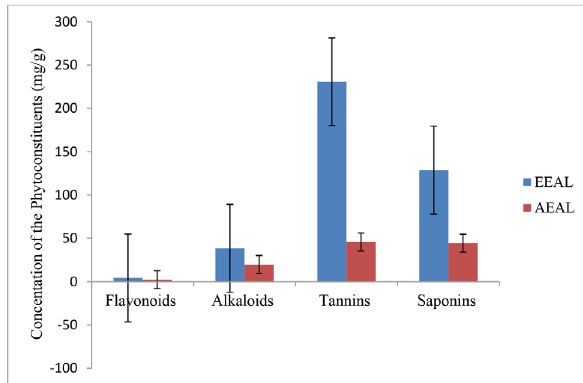
Figure 1 Quantitative phytochemistry of aqueous and ethanolic extracts of Albizia gummifera leaf; EEAL : Albizia gummifera